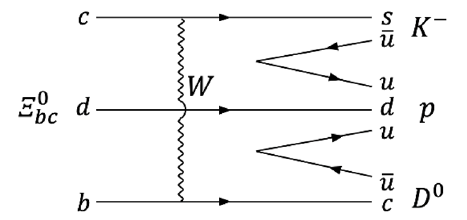
Figure 1 . The (cid:4) 0